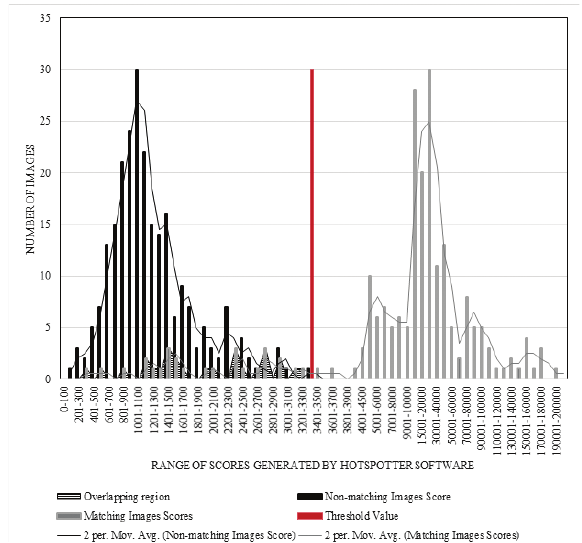
Figure 5. Histogram depicting the distribution of scores of matching images and non-matching images of Amolops formo- sus (n= 301) as generated by HotSpotter software. Black bars indicate the distribution of non-matching images scores, and the grey bars indicate the distribution of matching images score. Red bar is threshold value. Grey shaded region on the left side to threshold bar is an overlapping zone between the scores of matching and non-matching images.